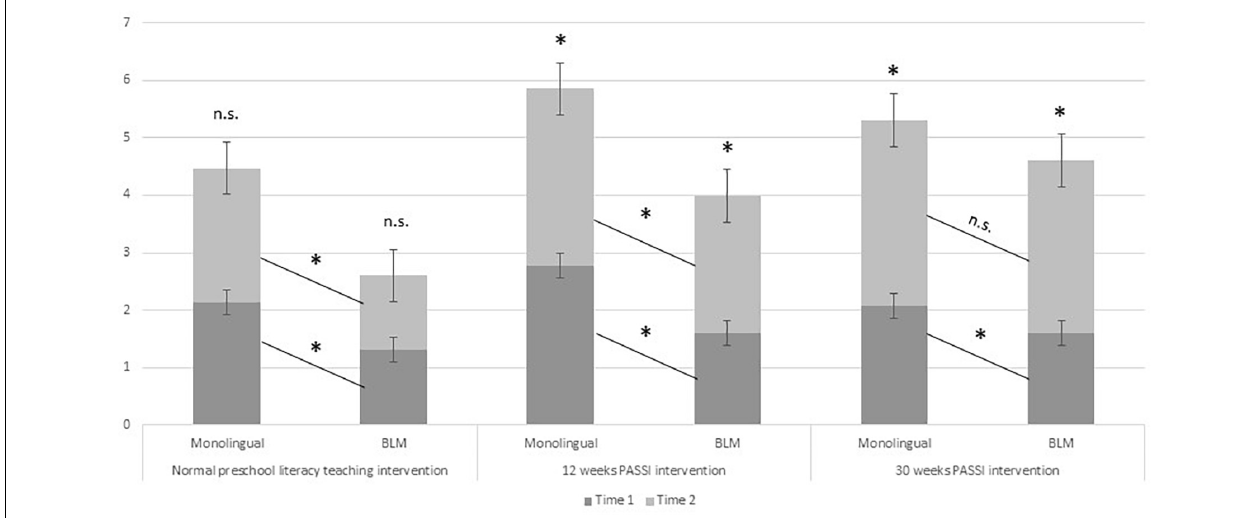
FIGURE 2 | Differences in notational knowledge scores within and between groups for each intervention condition. * Refers to statistically significant differences between and within groups.